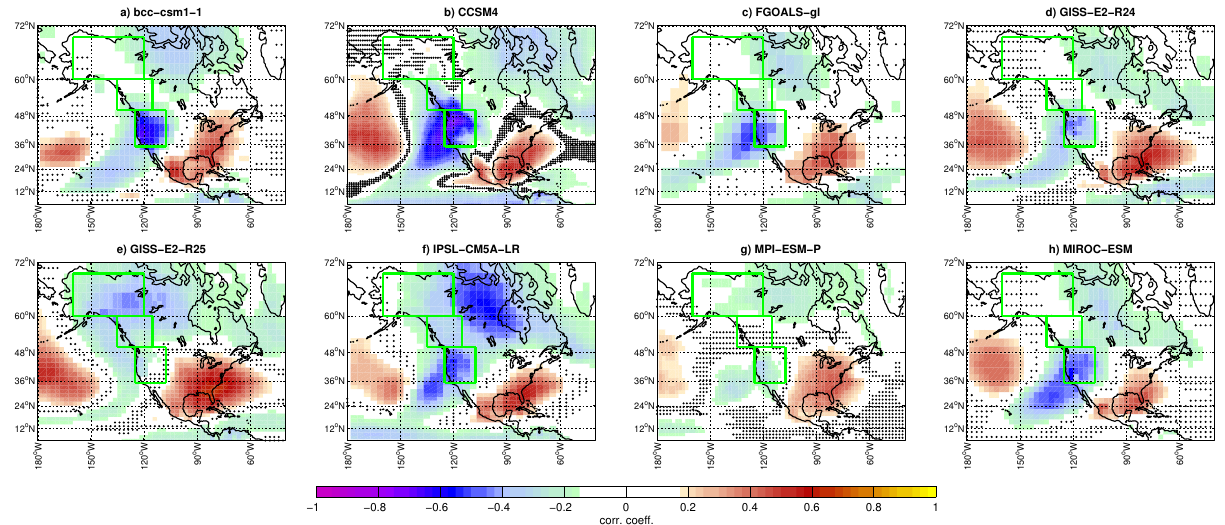
Figure 11. Correlation maps between the ensemble-average residuals (predicted value minus true value) from the winter (DJF) PNA pseudo- reconstructions obtained following the TT2010 approach and illustrated in Figs. 7a and 8 and winter surface air temperature time series for the pre-industrial period up to 1849. Dots mark grid points where the correlation is not significant at 95% confidence accounting for autocorrelation. The green boxes mark the areas used for the TT2010